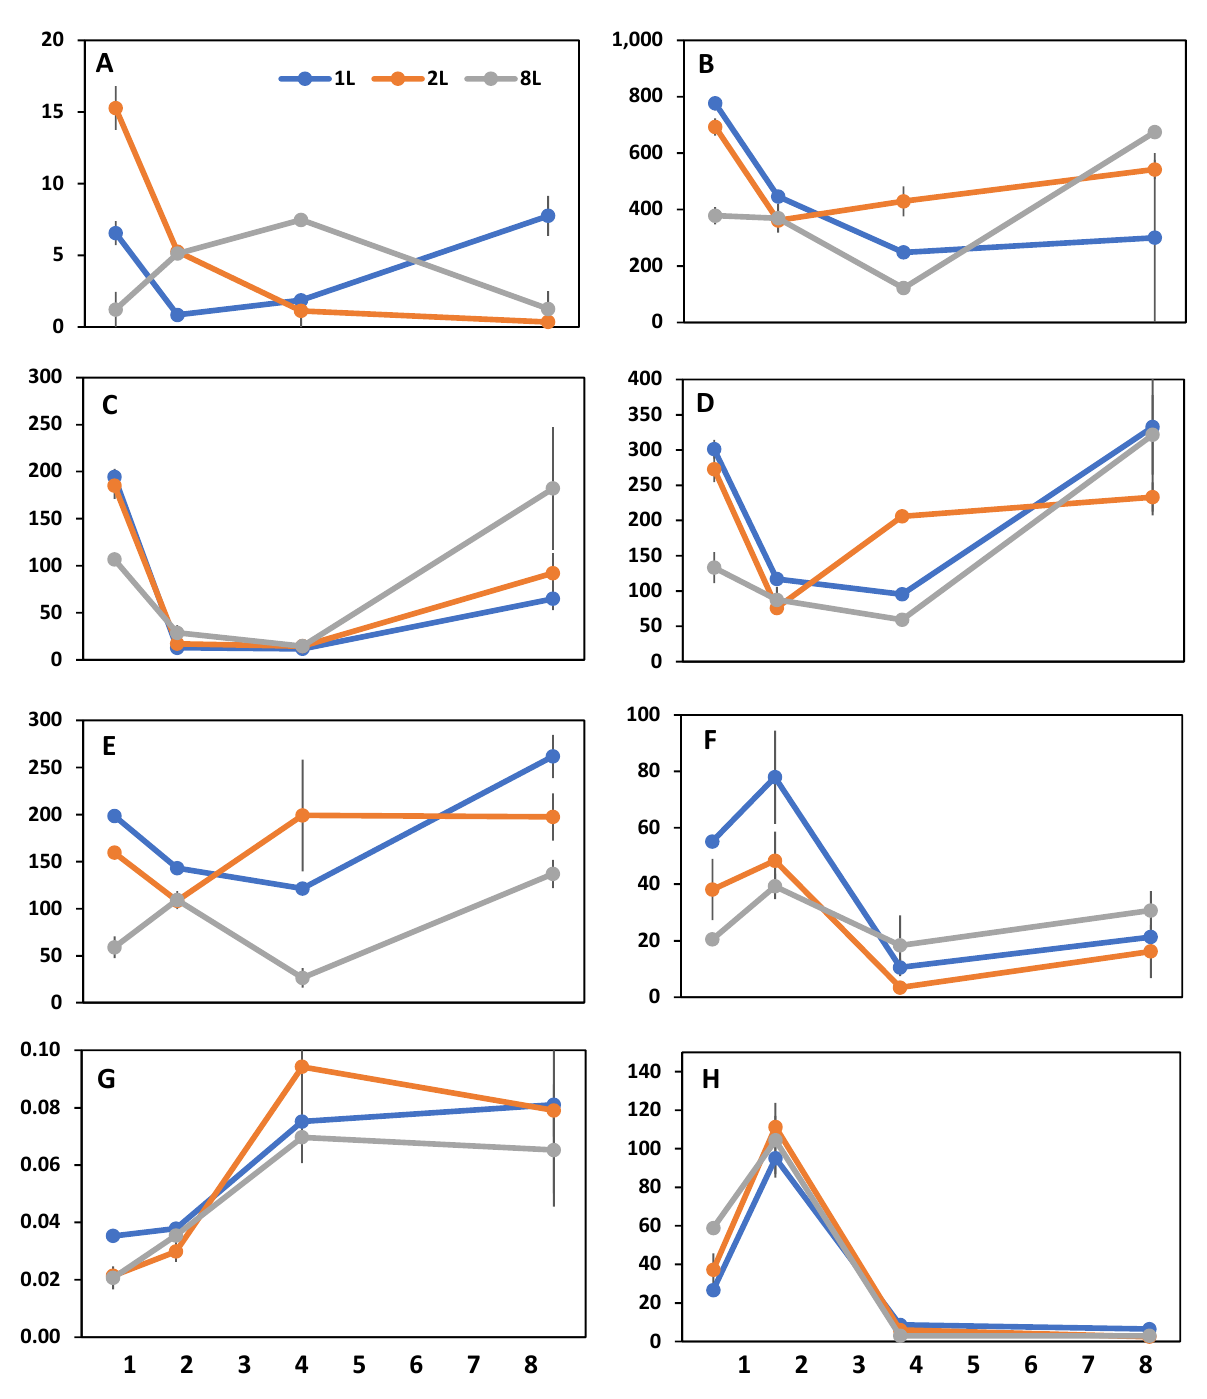
Figure 3. ( A ) Chlorophyll a concentration ( µ g L − 1 ) and ( B – H ) abundance ( × 10 4 cell L − 1 ) of phy- toplankton in the summer experiment. ( A ) Chlorophyll a concentration; ( B ) total abundance; ( C ) cyanobacteria; ( D ) eukaryotic picophytoplankton; ( E ) plastidic nanoflagellates; ( F ) cryptophytes; ( G ) dinoflagellates; and ( H ) diatoms, observed in bottles with variable volumes (1 L, 2 L, 8 L), subject to periods of incubation with the duration of 1 to 8 days. Vertical lines on each bar represent ± 1 standard error of the